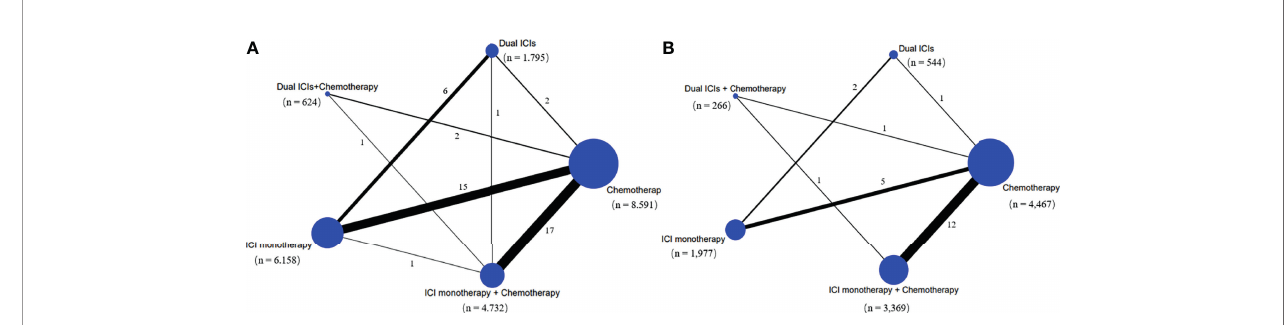
FIGURE 2 | Network map of comparisons based on fi ve treatments in grade 1-5 adverse events (A) and grade 1-5 immune-related adverse events (B) . Each circular node represents a type of treatment. The node size is proportional to the total number of patients administering a treatment (in parentheses). Each line represents a type of head-to-head comparison. The width of lines is proportional to the total number of studies comparing the connected treatments. ICI, immune checkpoint inhibitor; n, number.